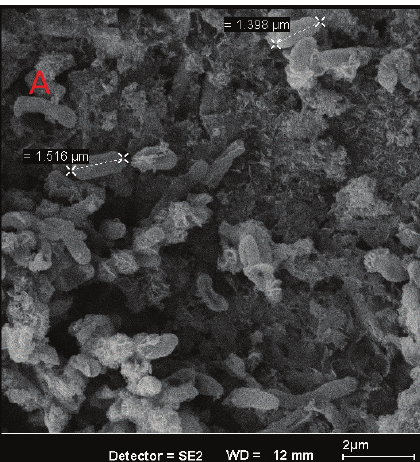
Figure 8: SEM images of the biofilms incubated at 37 ∘ C for 30 days for isolated Sg. Ular strain.